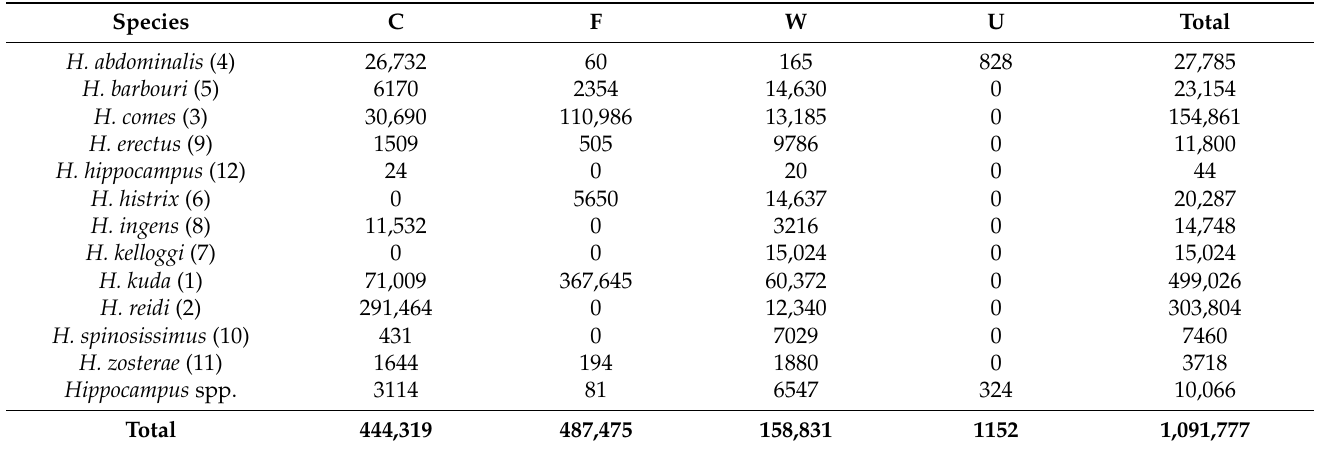
Table 4. Export numbers (individuals) of the most live-traded Hippocampus species worldwide over 2004–2018 [69] (ranking 1 to 12). Hippocampus spp. = other species and unidentified. Source: C = captive-bred, F = born in captivity, W = wild-caught, U = unknown and unmentioned. Re-exports are